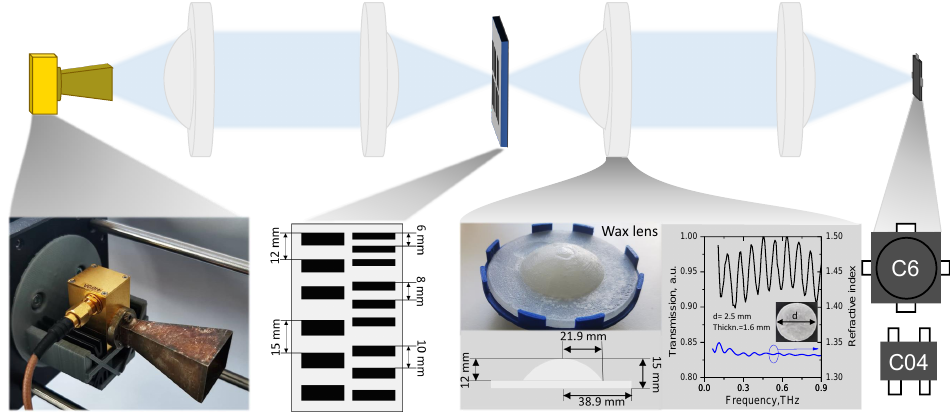
Figure 1. Schematic of the experimental setup and photos of the setup’s components with their parameters. Upper panel: As the THz radiation source serves the InP Gunn diode delivering radiation of 94 GHz in frequency with a power of 42 mW, 3D-printed paraffin wax lenses are used to collimate and focus the THz radiation, and CE3521M4 transistors operate as the THz detectors. Bottom panel: The photo of the Gunn diode, the parameters of the target produced from aluminum foil; photo of the paraffin wax lens, its geometrical parameters, and the dispersion curve of the refractive index; the composition of the layouts of the printed circuit boards of the investigated